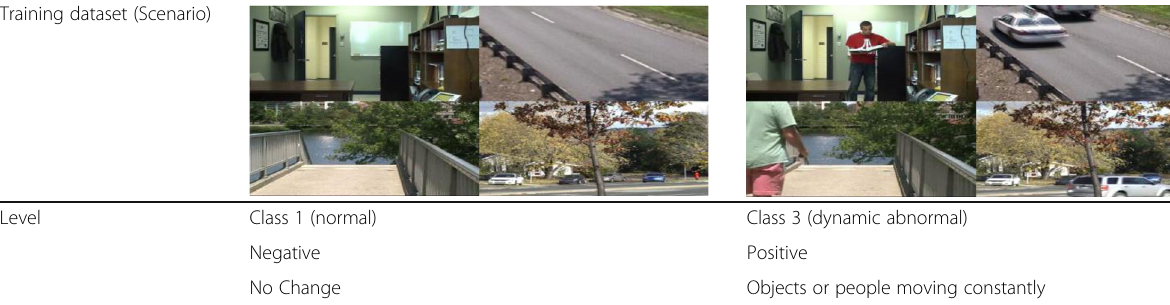
Table 5 Sample images classified into two levels Training dataset